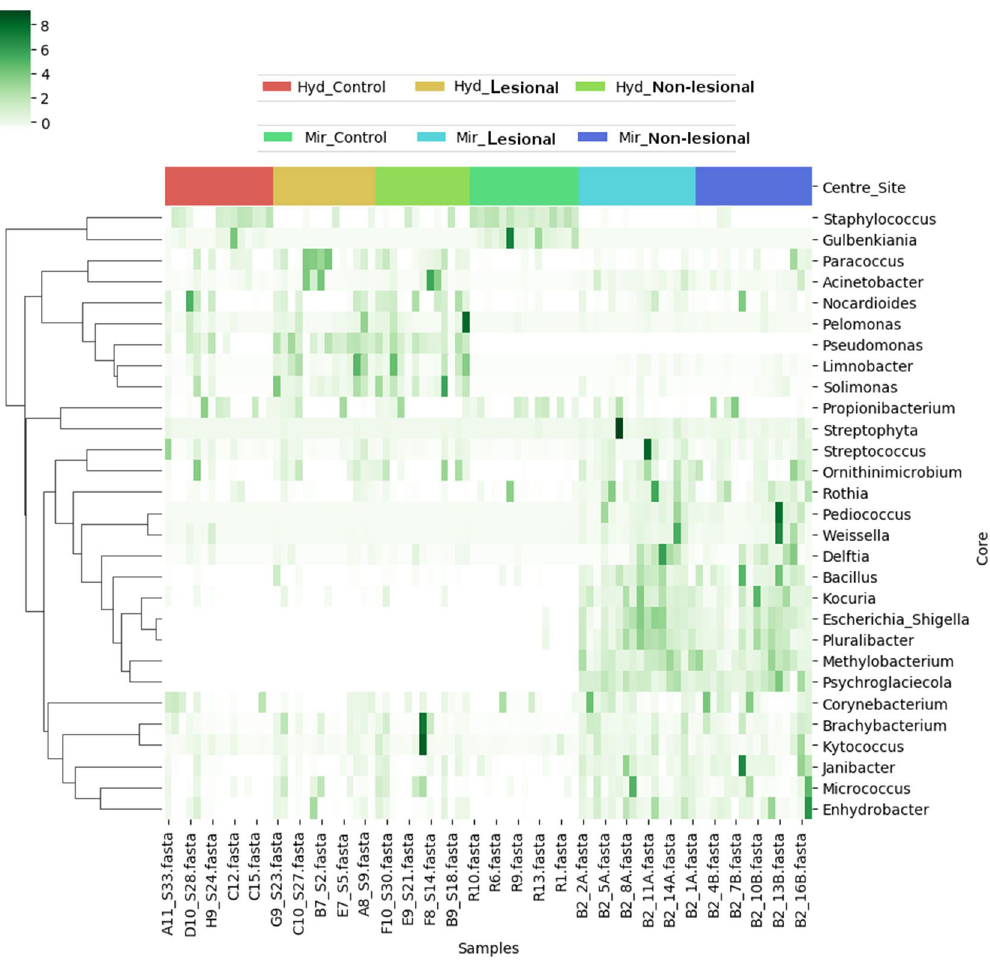
Figure 7. Core bacterial genera within and across various sample sets in both geographies. Core bacterial genera identified in samples obtained from HC, LS and NLS sites of LP from Hyderabad and Miraj. These genera were observed to be present in ≥ 70% of the samples in the respective sample set with minimum 0.1% relative